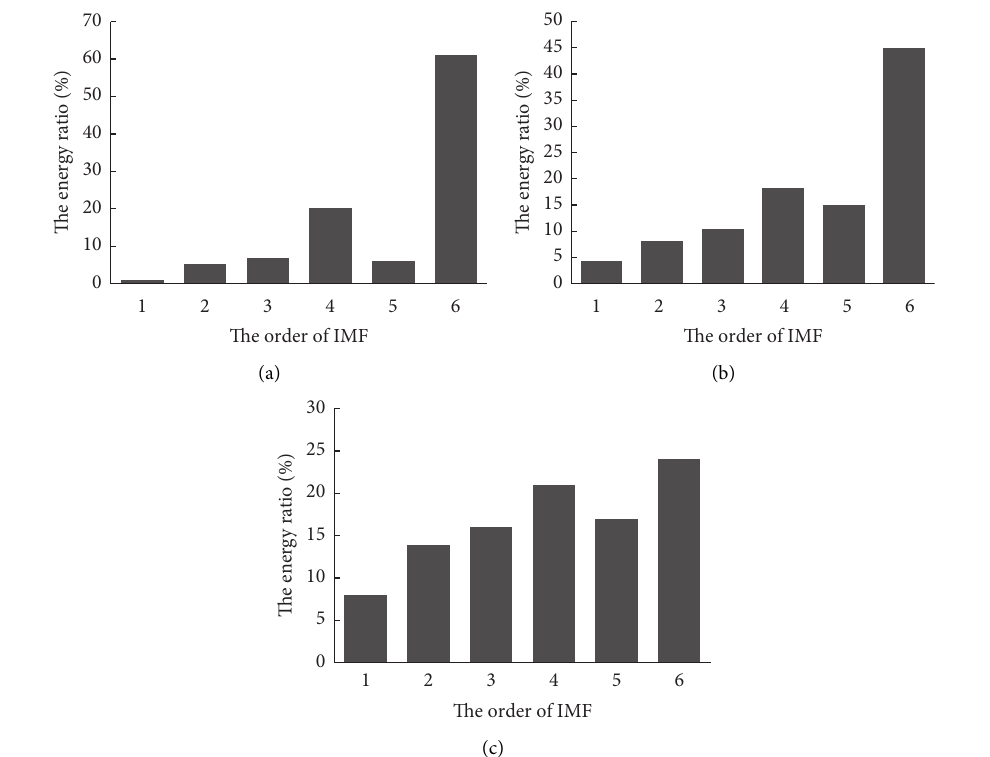
Figure 6: Energy ratio based on EEMD under three states. (a) Mixed lubrication (20 th min), (b) boundary lubrication (60 th min), and (c) dry friction (80 th